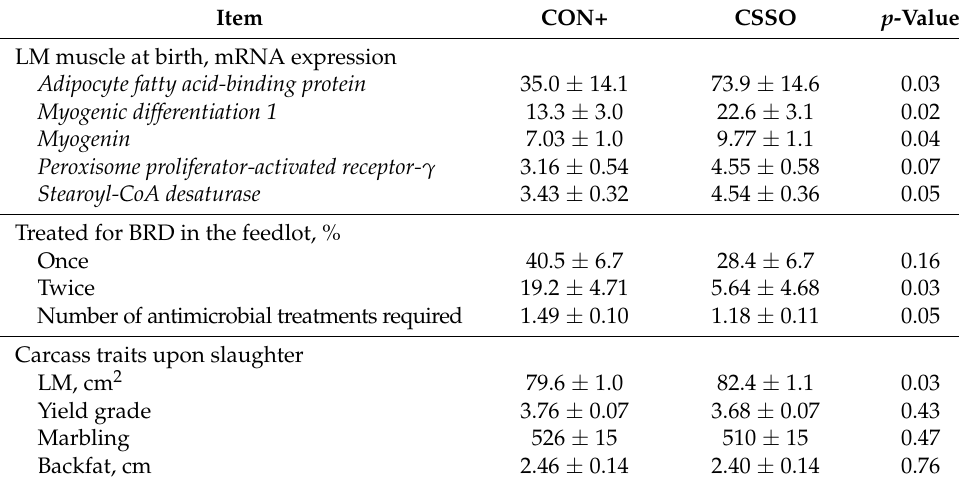
Table 4. Expression of mRNA (relative fold change) of longissimus muscle (LM) genes at birth, incidence and treatments against bovine respiratory disease (BRD) in the feedlot, and carcass traits of calves born from cows that received diets supplemented with Ca soaps of soybean oil (CSSO; n = 52) or prilled saturated fat (CON+; n = 52) during the last trimester of gestation. Values reported are least square means ± standard error. Adapted from Brand ã o et al. [42]. Item CSSO p